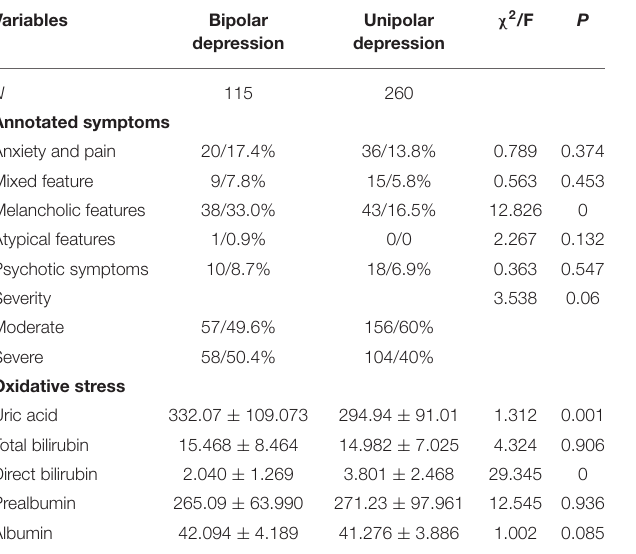
TABLE 3 | Symptoms and oxidative stress related indicators in patients who developed unipolar and bipolar depression in summer.